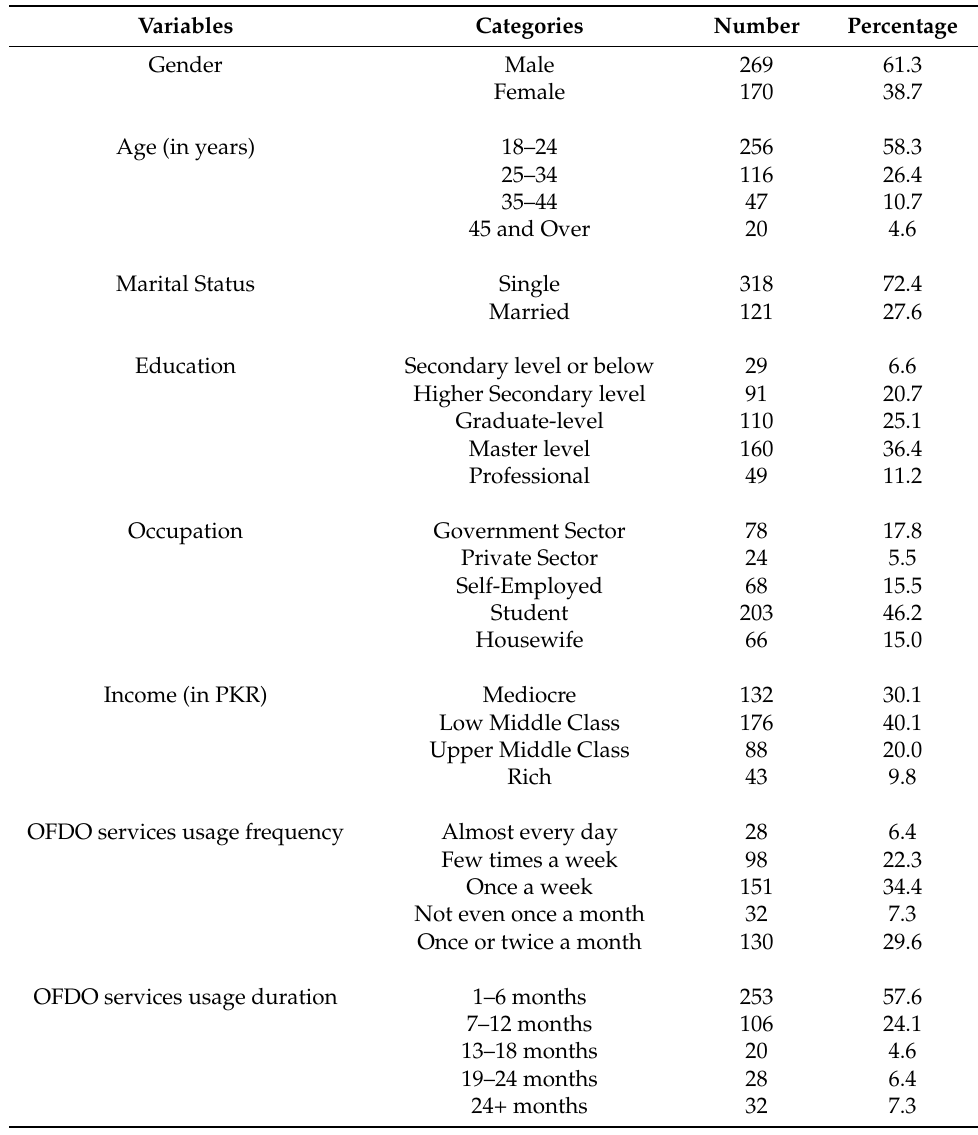
Table 1. Respondents’ demographic